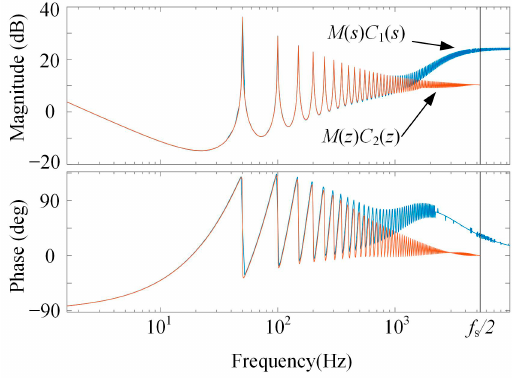
Figure 8. Bode plots of M ( s ) C 1 ( s ) and M ( z ) C 2 ( z ).